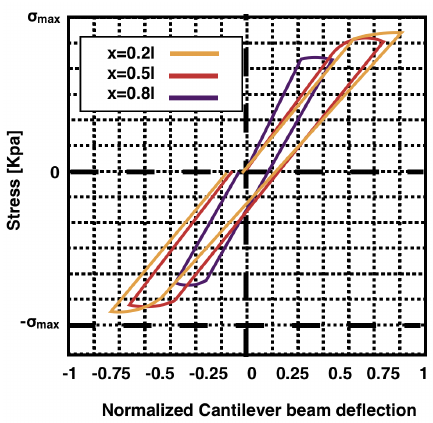
Figure 4. Hysteresis analysis of the cantilever beam as experiences deflection due to perpendicular stress while the clutch location is at x = 0.2 l , x = 0.5 l and x = 0.8 l .